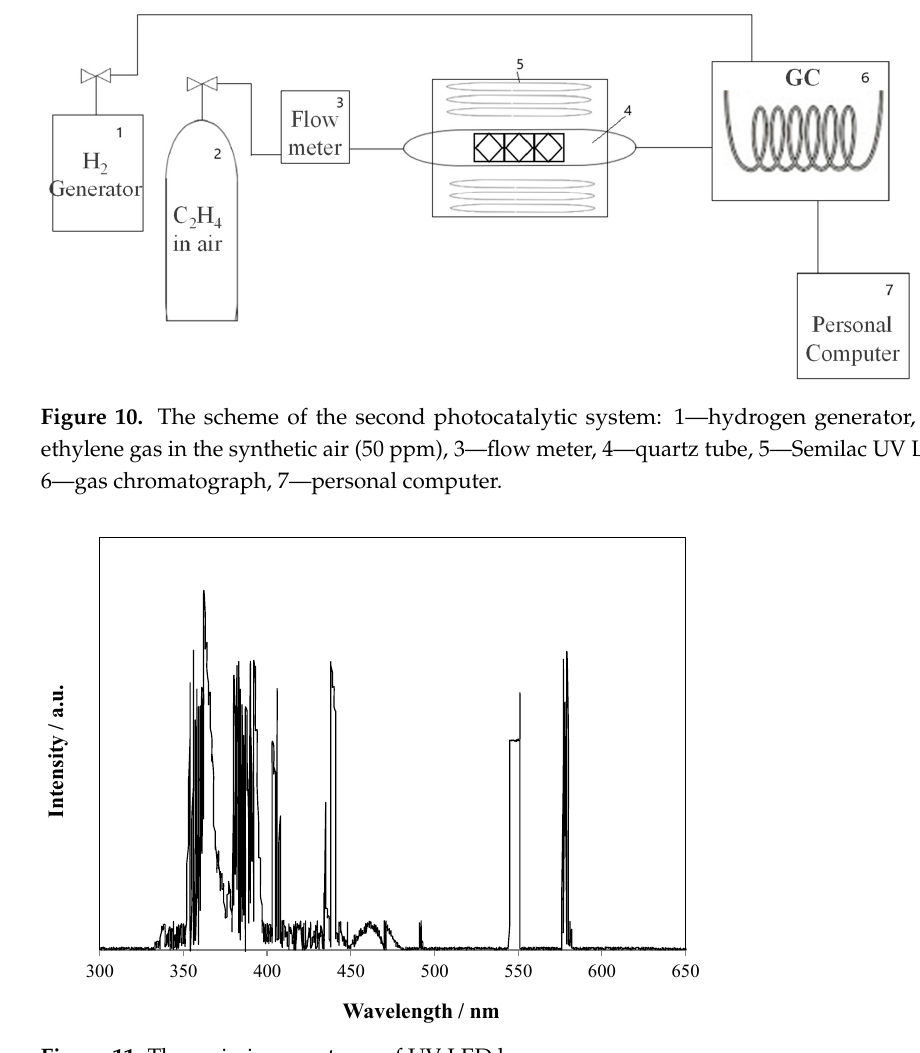
Figure 11. The emission spectrum of UV LED lamps.